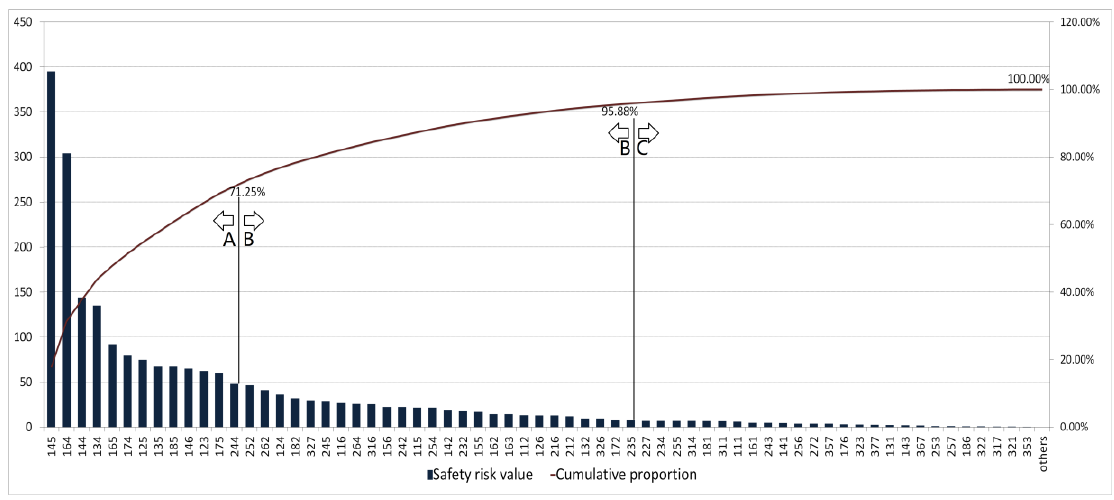
Figure 8. Importance degree of safety risk management processes by ABC analysis.